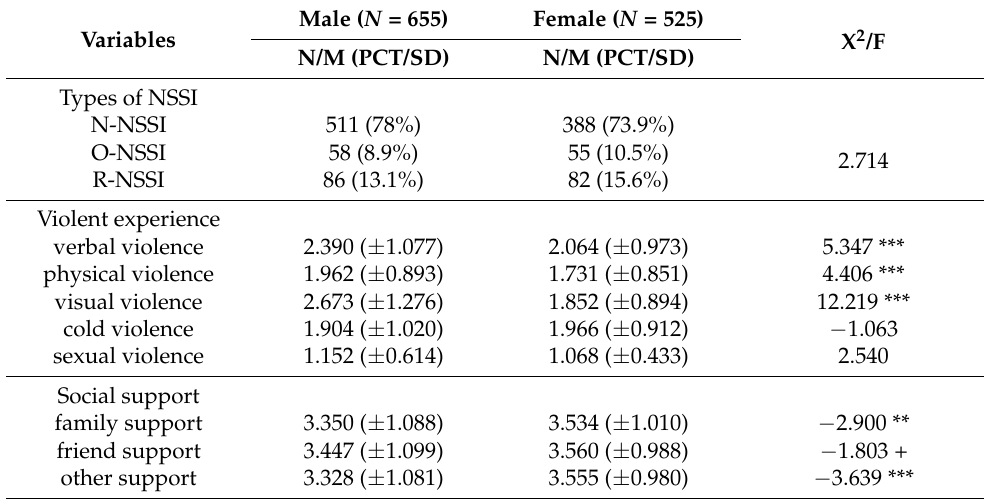
Table 1. Sex differences in variable measurement.